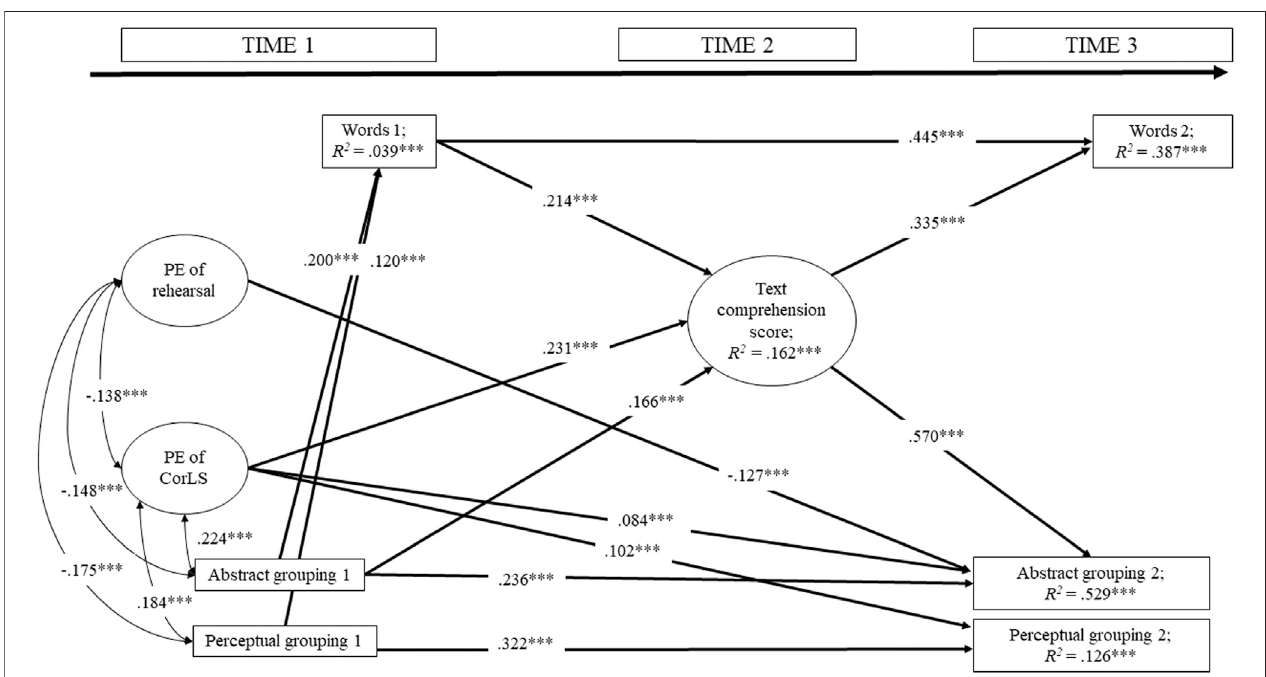
FIGURE 3 | Standardized solution of Structural Equation Model in Grade 9. Only signi fi cant paths and correlations are shown; *** p < 0.001.